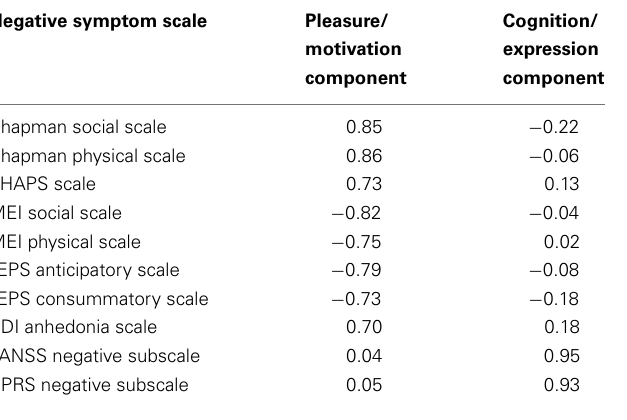
Table 2 | Pattern matrix of principal component analysis for the 10 negative symptom scales .